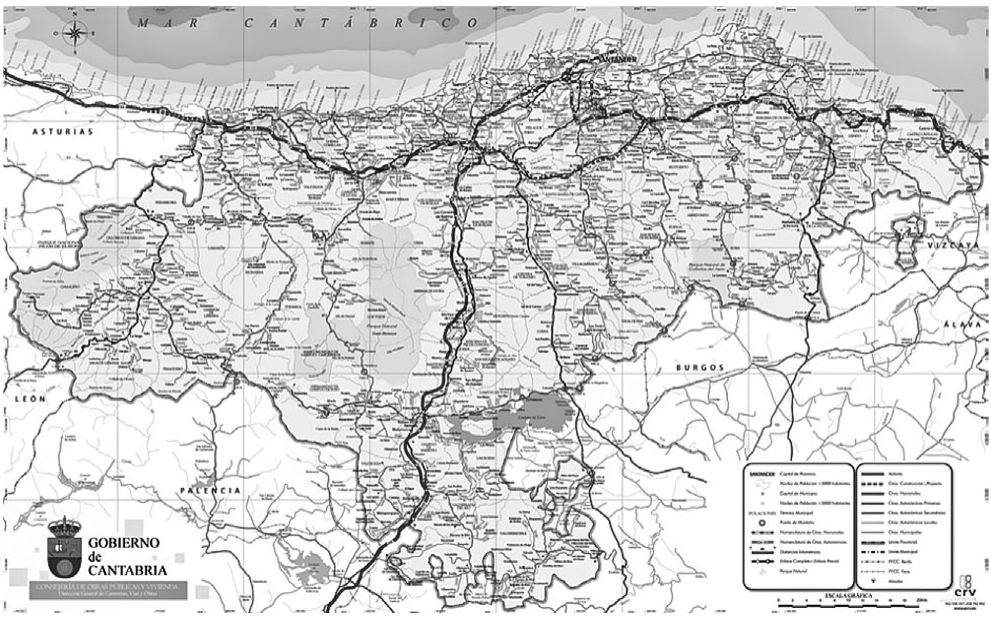
Fig. 3. Road Network of the Autonomous Community of